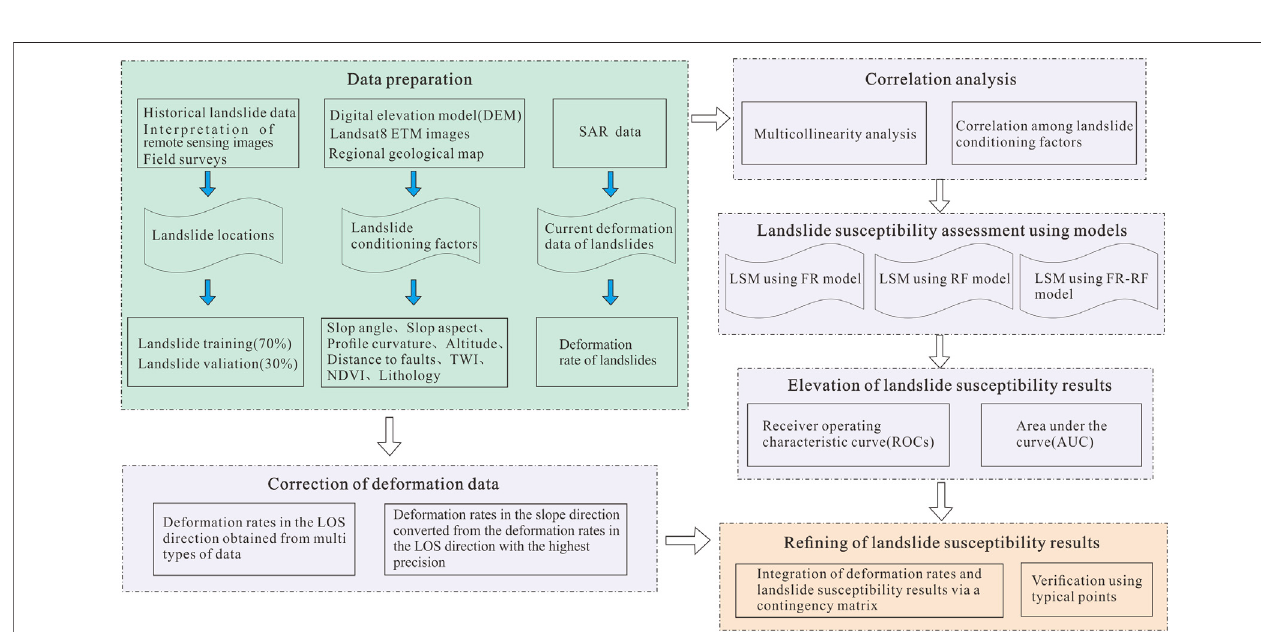
FIGURE 2 | Research